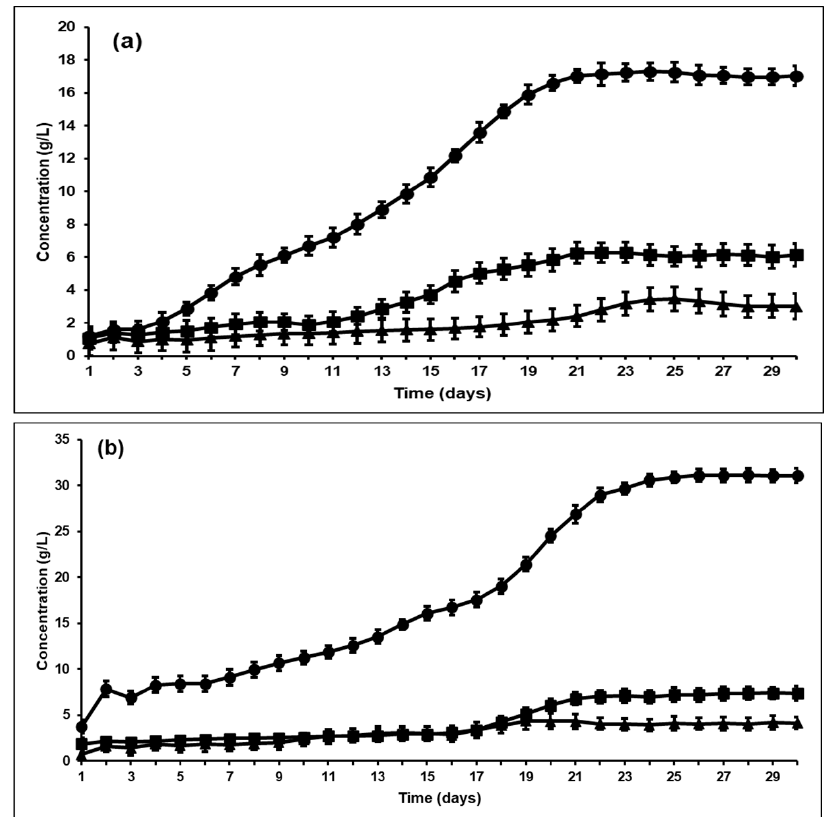
Figure 4. VFA (g/L) concentration as a function of time in bioreactors after BES addition and bioaugmentation with ( a ) Acetitomaculum ruminis and ( b ) Acetobacterium woodii ( • Acetic acid concentration (g/L); (cid:4) Propionic acid concentration (g/L); (cid:78) Butyric acid concentration (g/L)).